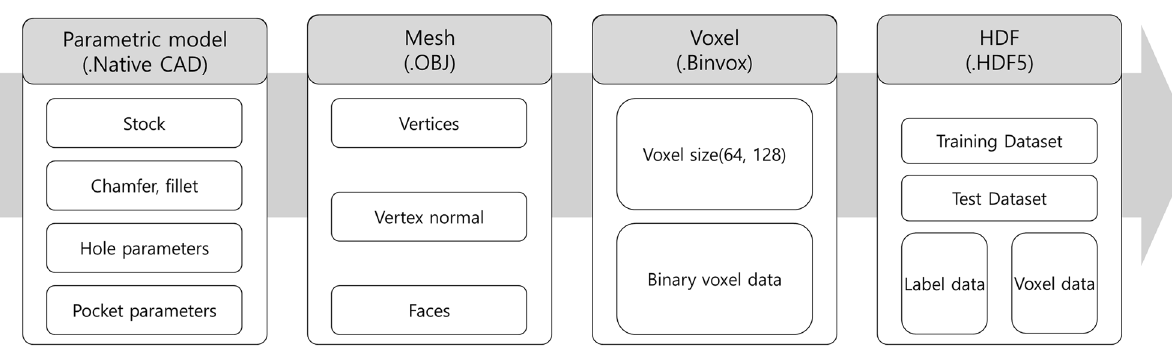
Figure 2. 3D CAD model generation and conversion